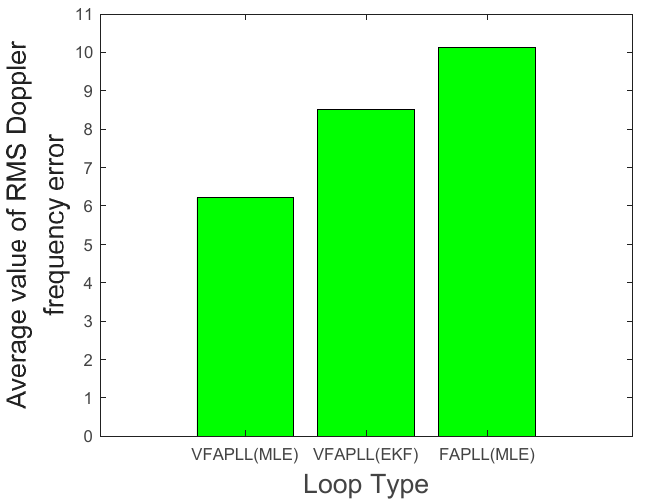
Figure 8. Comparison of the mean values of the VFAPLL (MLE), VFAPLL (EKF) and FAPLL (MLE) RMS Doppler frequency errors under different acceleration scenarios when CNR = 23dB/Hz.